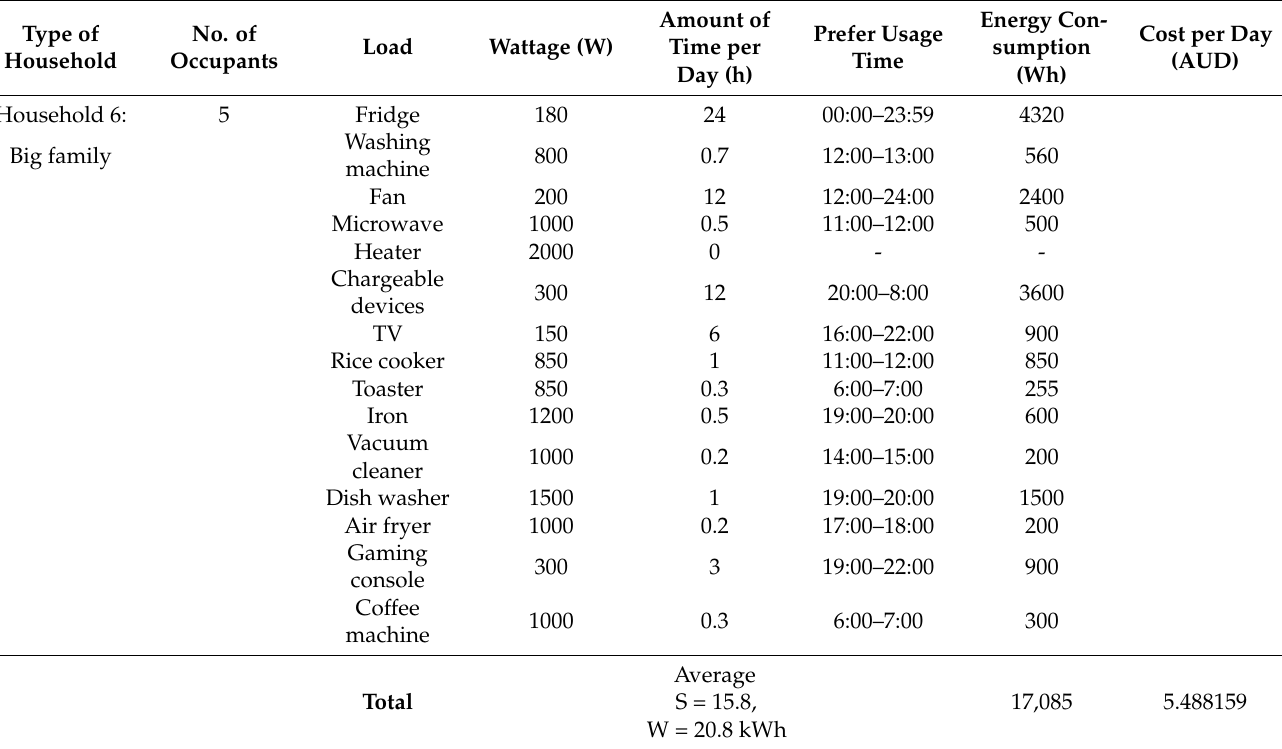
Table 8. Initial load profile 6 created for the project